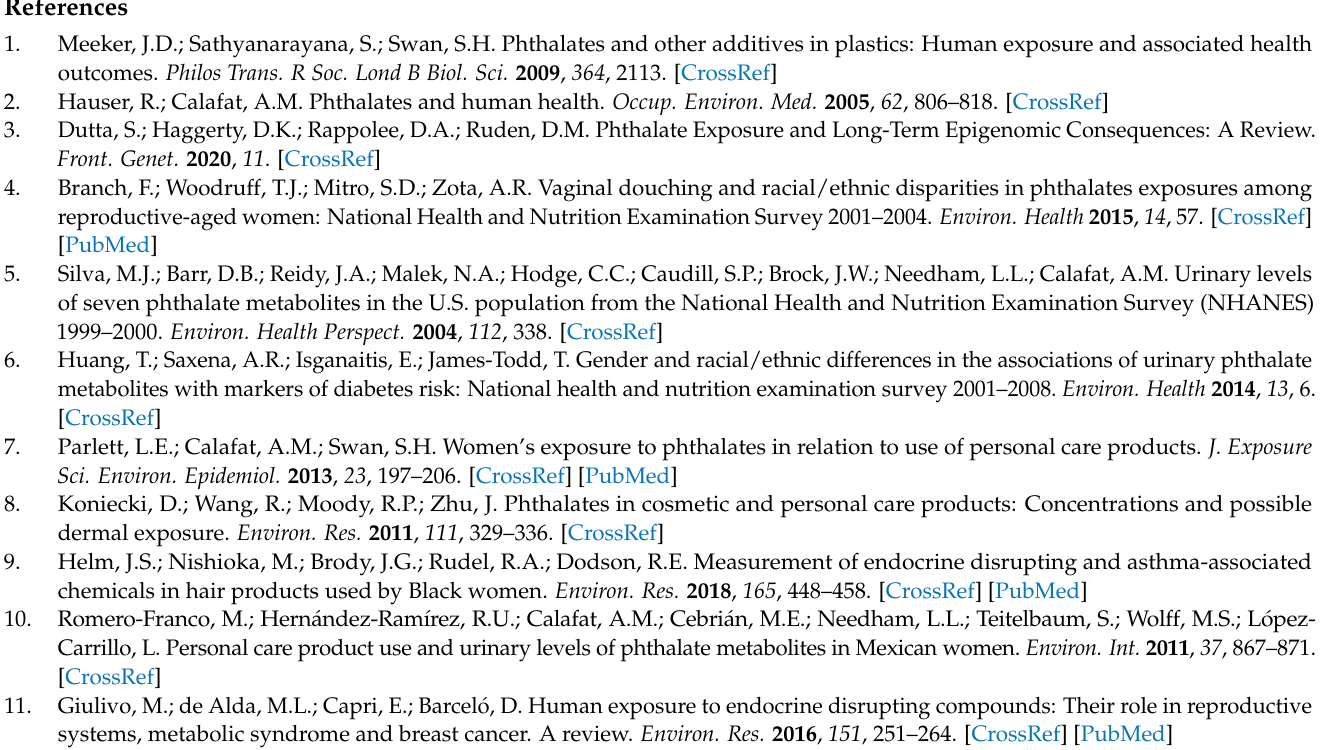
Table S6: Overall Associations between Urinary Phthalate Metabolites and Metabolic Syndrome, NHANES (2005–2014), Table S7: Associations between Urinary Phthalate Metabolites and Metabolic Syndrome by Sex, NHANES (2005–2014), Table S8: Overall Associations between Urinary Phthalate Metabolite Summary Measures and Metabolic Syndrome, NHANES (2005–2014), and Table S9: Associations between Urinary Phthalate Metabolite Summary Measures and Metabolic Syndrome by Sex, NHANES